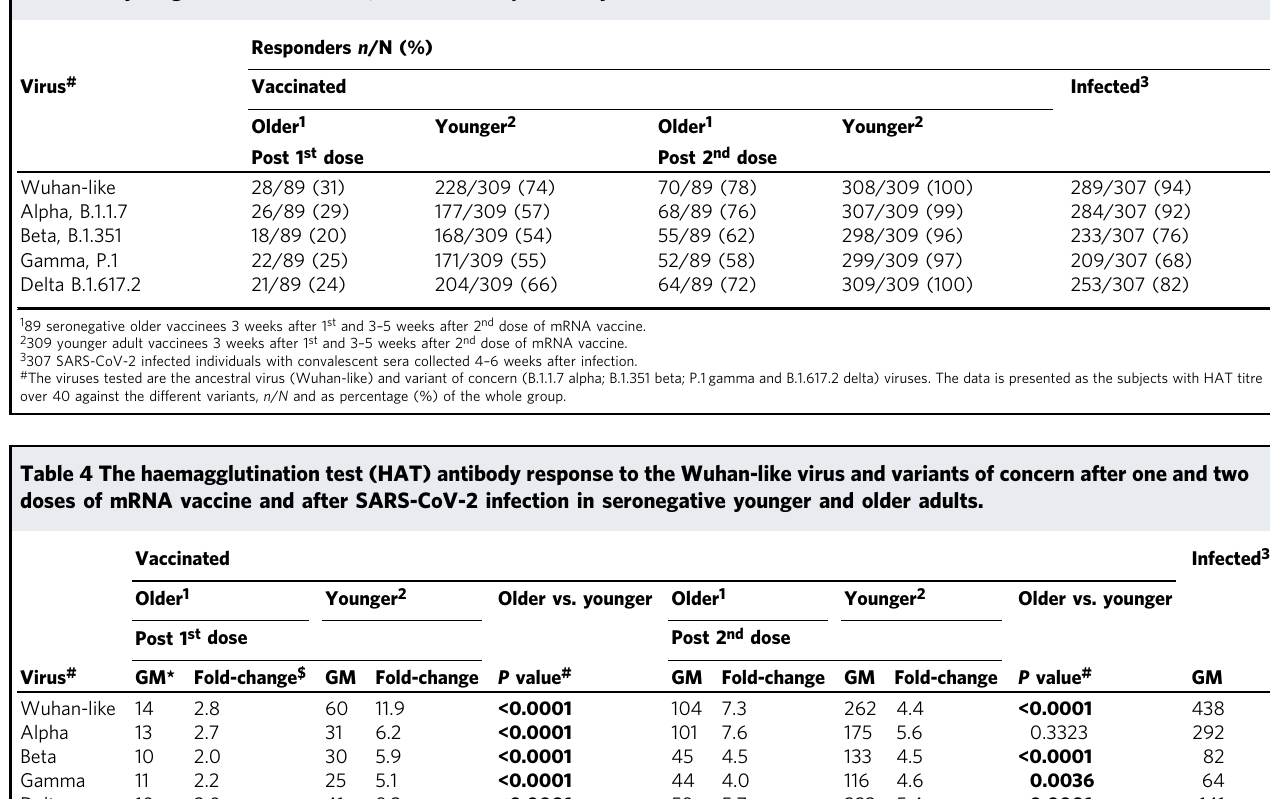
Table 3 Comparison of Wuhan-like and variant of concerns haemagglutination test responders after one and two doses of mRNA vaccine in younger and older adults, as well as in previously infected individuals with SARS CoV-2.